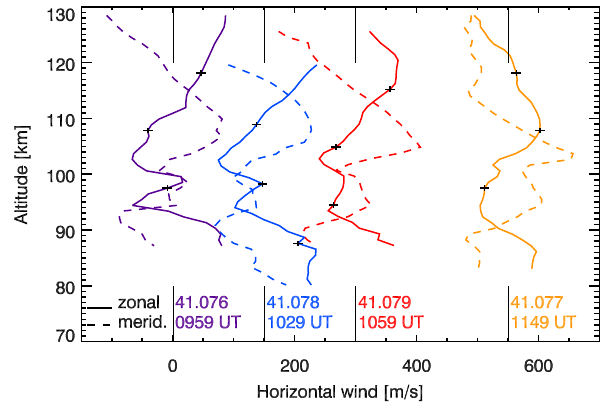
Fig. 3. Zonal and meridional wind profiles calculated from the four upleg TMA releases. Profiles are shifted horizontally relative to the first profile.